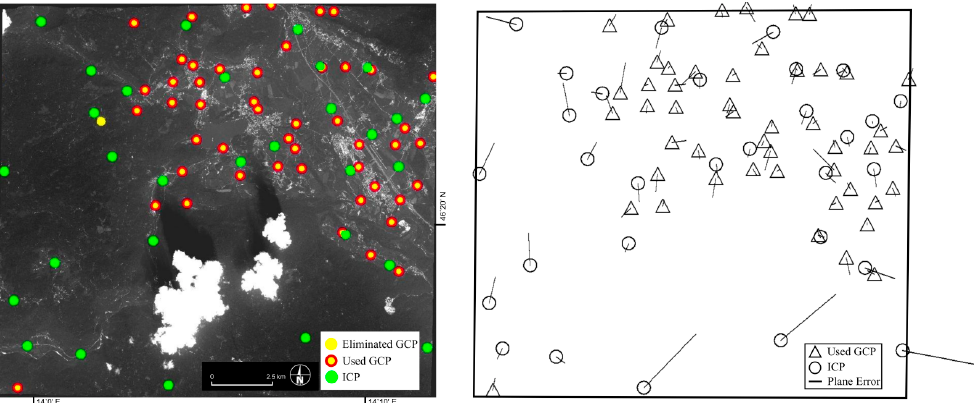
Figure 12. Distribution ( left ) and residuals ( right ) of automatically extracted GCPs and manually digitized ICPs on the Bled WorldView-2 image, which was processed with the three-step GCP extraction algorithm and the physical sensor model. The right image clearly shows the dependency of the physical sensor model on the distribution of the GCPs—parts of the image without any GCPs manifest in increased ICP residuals. Table 5. Accuracy of the adjustment results obtained with the physical sensor model on different subsets of automatically extracted GCPs for three multispectral WorldView-2 1B images.